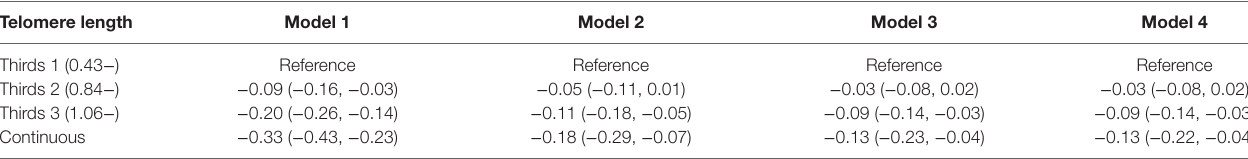
TaBle 2 | Association between telomere length and C-peptide, β (95% CI).